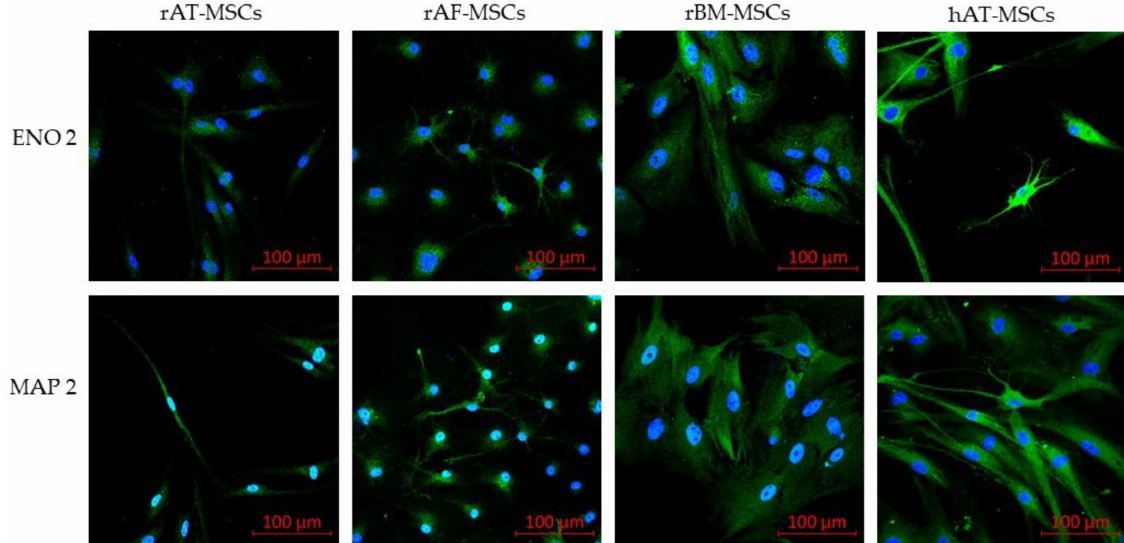
Figure 9. Confocal microscopy of specific neural markers. Neural markers ENO2 and MAP2 were highly expressed in all differentiated rabbit mesenchymal stem cells (rMSCs) as well as in human adipose tissue-derived mesenchymal stem cells (hAT-MSCs); rAT-MSCs—rabbit adipose tissue-derived mesenchymal stem cells; rAF-MSCs—rabbit amniotic fluid mesenchymal stem cells; rBM-MSCs—rabbit bone marrow mesenchymal stem cells; ENO2—neuron-specific enolase; MAP2—microtubule-associated protein 2; (Scale bars = 100 µ